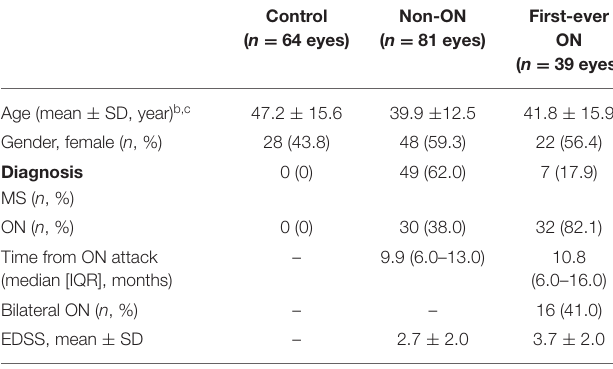
TABLE 1 | Baseline characteristics according to study groups a